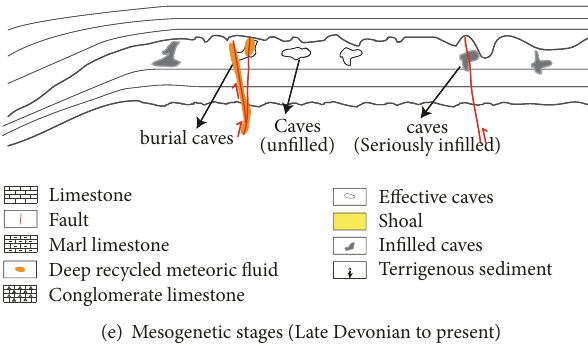
Figure 11: Diagenetic evolution and reservoir formation models of Lianglitag Formation